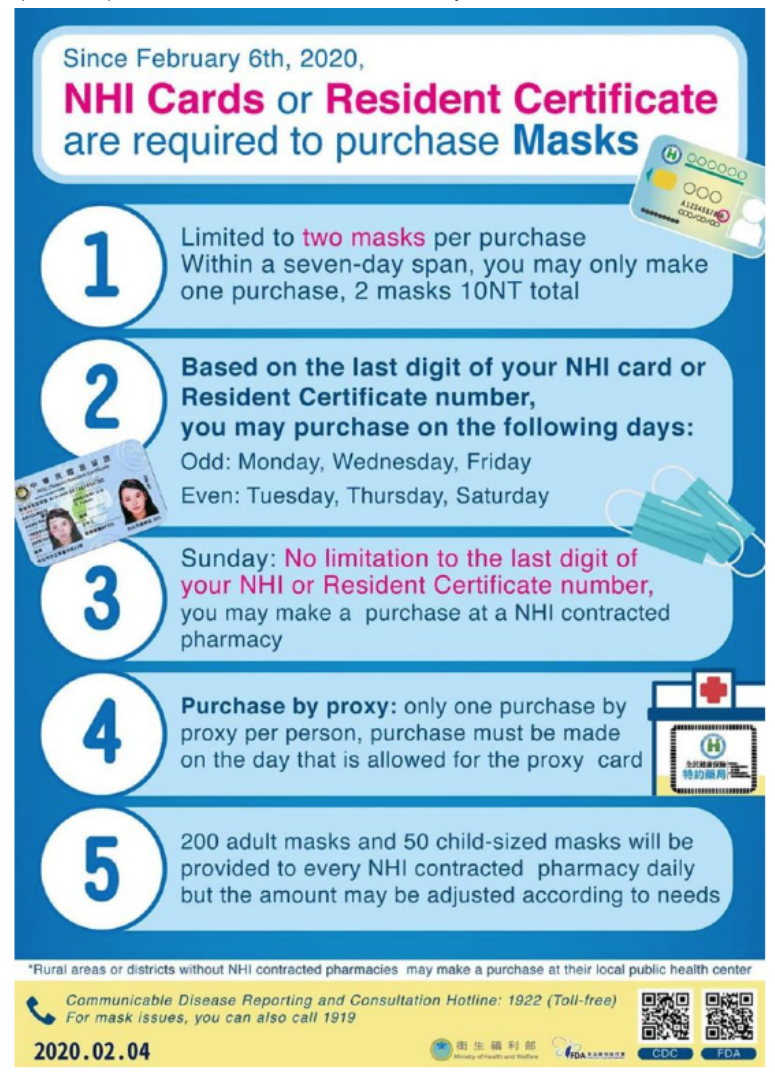
Figure 2. Mask rationing plan 1.0, published on the Ministry of Health and Welfare's Facebook page. Illustration of a new procedure for purchasing medical face masks, which was announced by the Ministry of Health and Welfare of Taiwan on February 6, 2020. Surgical masks can be purchased at local pharmacies upon presentation of a National Health Insurance card. Medical staff are permitted 1-2 masks per day and others can purchase 3 masks per week. A real-time mask map website provided information on mask